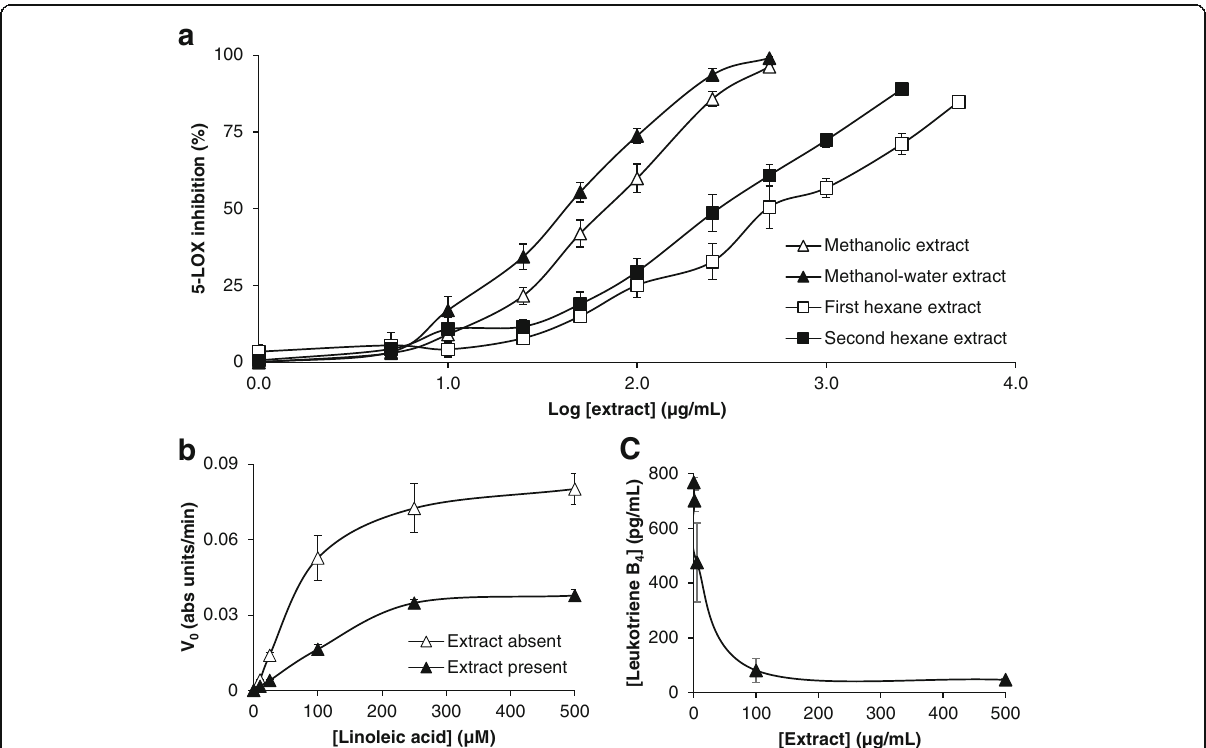
Fig. 4 Inhibitory effects of T. carbonaria cerumen on the pro-inflammatory 5-LOX-LTB 4 signaling pathway in vitro (mean ± SEM). A methanolic cerumen extract dose-dependently inhibited the 5-LOX-mediated oxidation of linoleic acid ( a ), through reduced V max and increased K m ( b ; P < 0.05; n = 3). The extract additionally inhibited LTB 4 production in human neutrophils stimulated with 2 μ M ionomycin ( c ; n = 4). Following multi-solvent extraction, the methanol-water cerumen extract inhibited 5-LOX activity with greater potency than the first and second hexane extracts (a; P < 0.05; n =